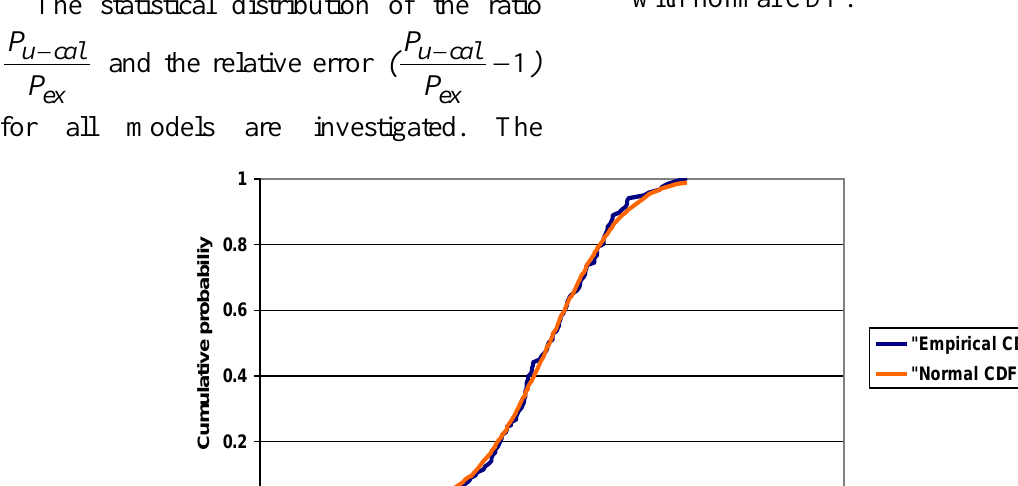
PP excalu  9 ratio.